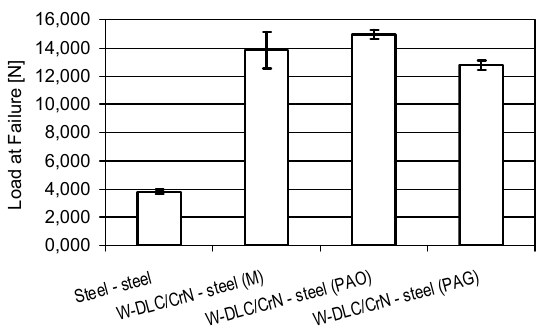
Figure 7. Loads at failure obtained in the scuffing tests.